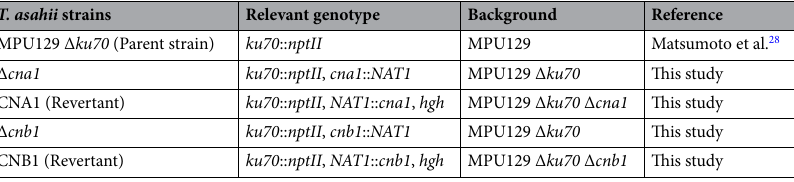
Table 2. T. asahii strains used in this